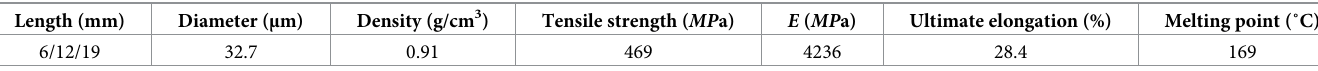
Table 3. Physical and mechanical properties of polypropylene fibers.